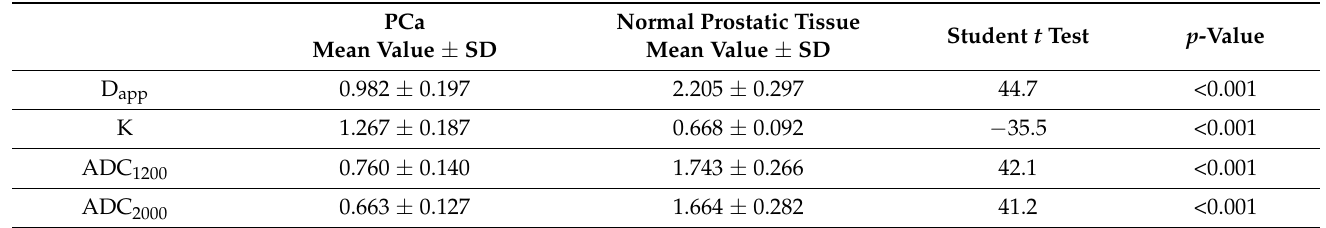
Figure 2. Box-and-whisker plots of DKI parameters and standard ADC in prostate cancer and corresponding normal tissue ( p < 0.001). *** stands for p < 0.001. Both ADC 1200 and ADC 2000 tumor mean values were significantly lower (0.760 ± 0.140 and 0.663 ± 0.127) than that of mean values obtained from normal prostate tissue (1.743 ± 0.266 and 1.664 ± 0.282). The mean value of D app was significantly lower in tumor (0.982 ± 0.197) compared to healthy tissue (2.205 ± 0.297), and K values were significantly higher in tumor (1.267 ± 0.187) compared to healthy tissue (0.668 ± 0.092). Mean D app values in both tumor and normal prostate tissue were significantly higher than standard ADC values ( p < 0.001) as shown in Table 2. Table 2. DKI diffusion parameters and ADC in cancer and control benign tissue of